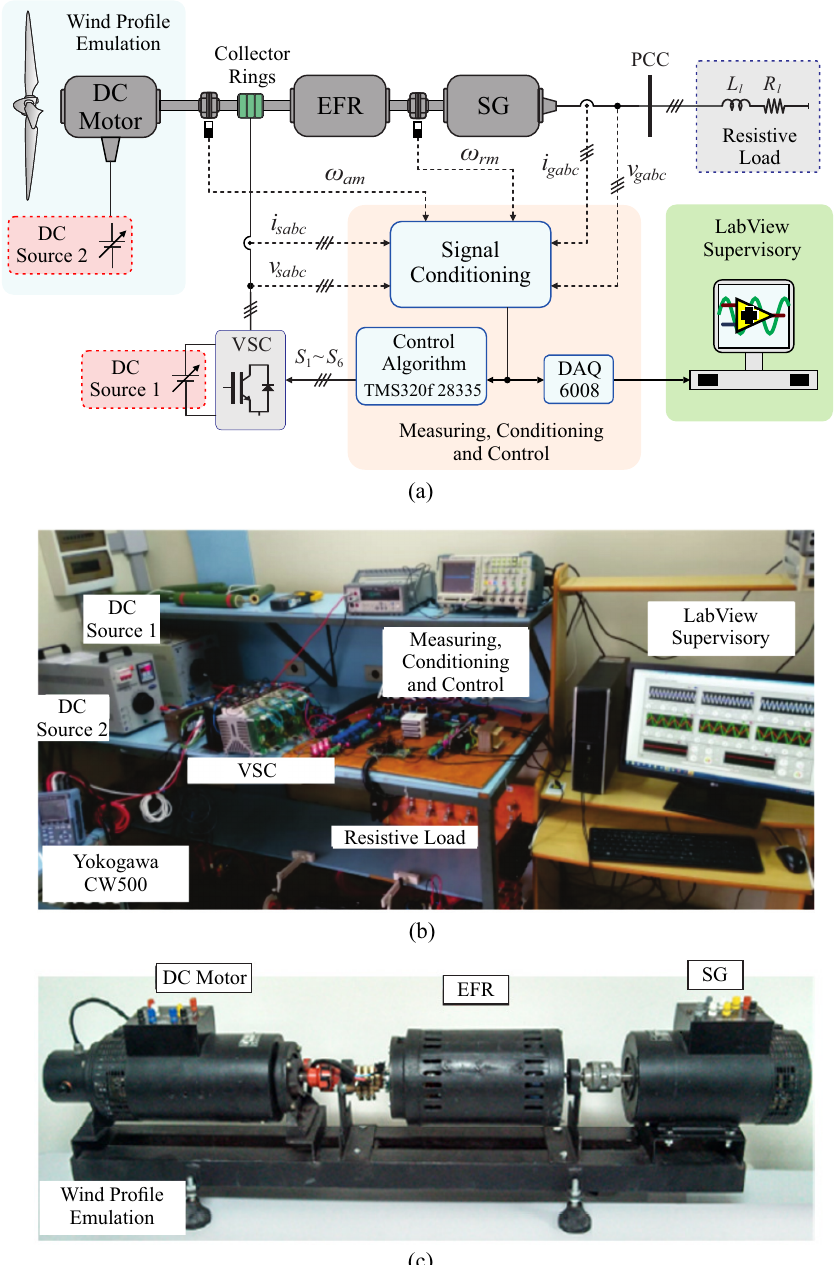
Figure 18. Experimental platform: ( a ) block diagram, ( b ) layout of laboratory equipment and ( c ) prototype